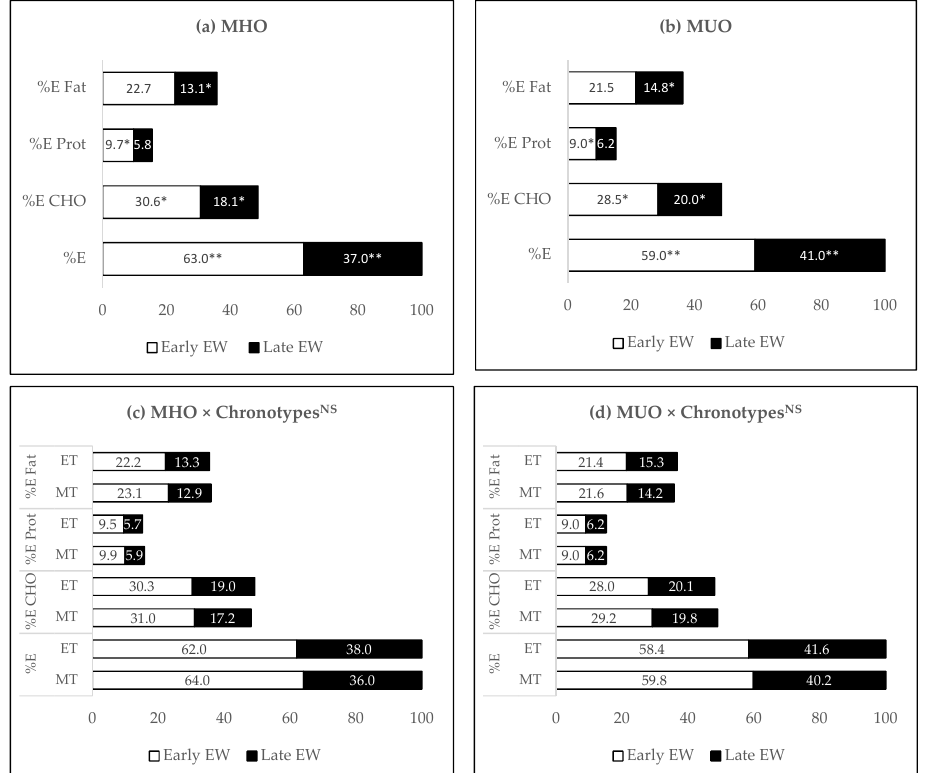
Figure 1. The temporal patterns of intake—the distribution of percentage total energy and percentage of energy from macronutrients (carbohydrate, protein, and fat) in the early and late windows. ( a ) MHO ( b ) MUO ( c ) MHO × chronotypes and ( d ) MUO × chronotypes. * Significant difference between MHO and MUO at p < 0.05, ** p < 0.01 using ANCOVA adjusted for age, gender, and BMI. NS No significant interaction effect of metabolic health status and chronotypes observed using two-way ANOVA adjusted for age, gender, and BMI. Abbreviations: MHO, metabolically healthy obesity; MUO, metabolically unhealthy obesity; E, energy; CHO, carbohydrate; Prot, protein; M, morning chronotypes; E, evening chronotypes.